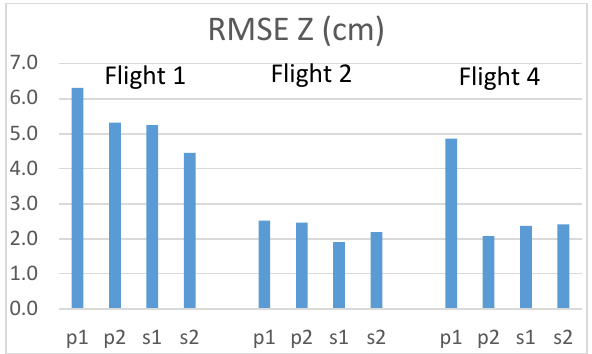
Figure 5. RMSE in elevations at CP